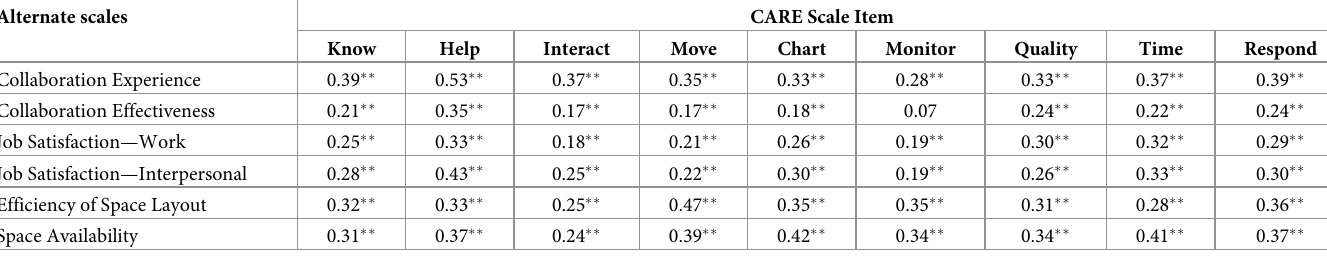
Table 14. CARE scale item correlation with external